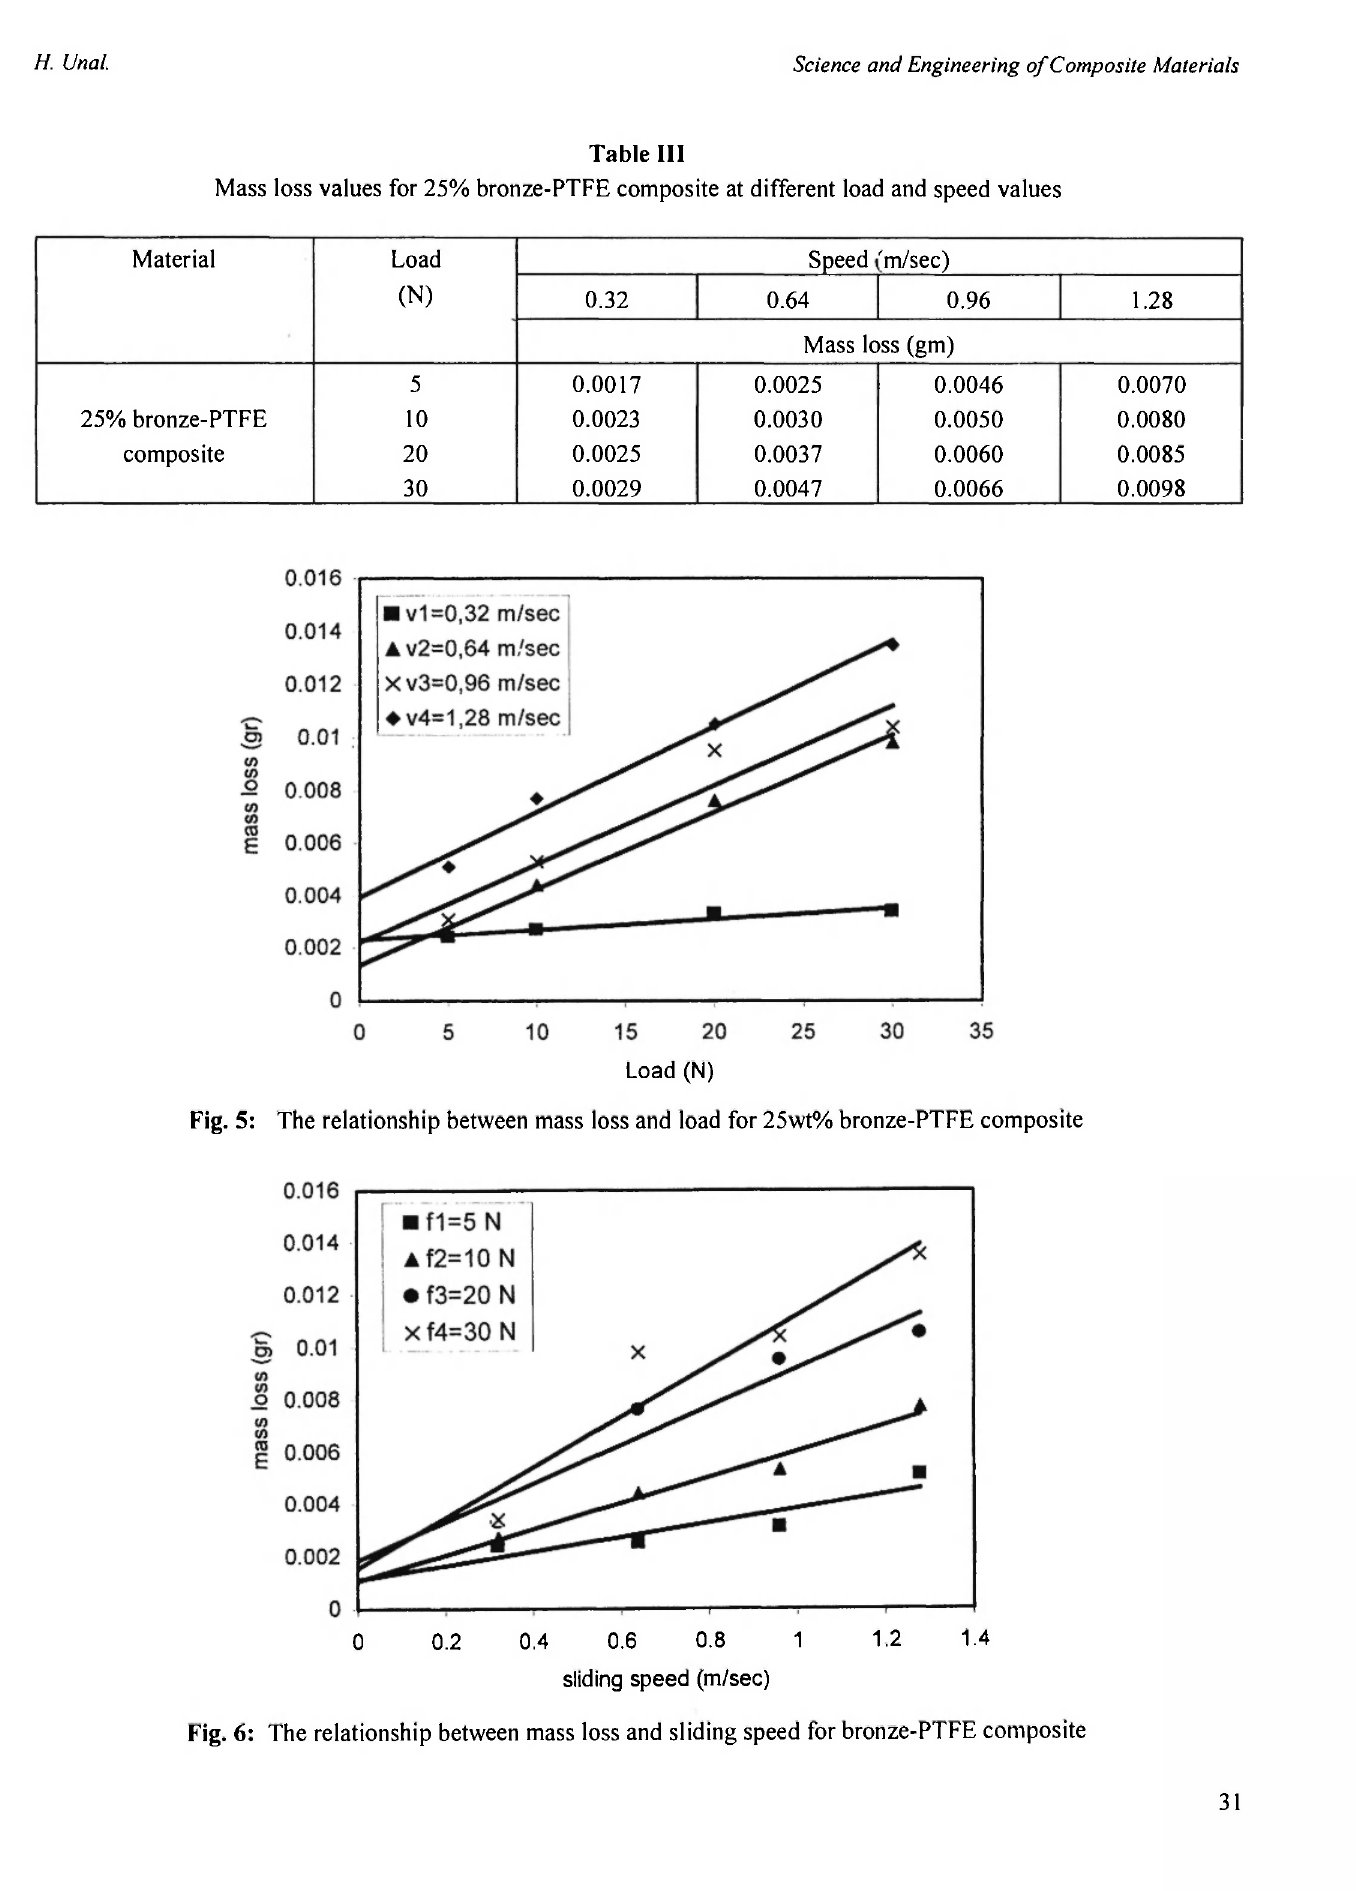
Fig. 5: The relationship between mass loss and load for 25wt% bronze-PTFE composite